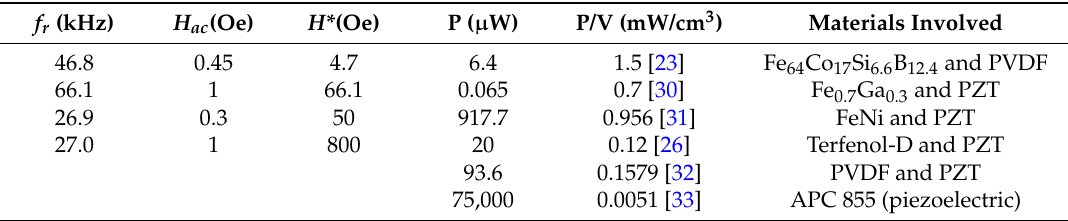
Table 2. Comparison of some power output and power densities values reported so far for some ME laminates. f r , H ac and H* refer to the resonance (or working) frequency, the AC excitation field and DC field, respectively, for the maximum ME coupling. Table adapted from [23] with permission of the